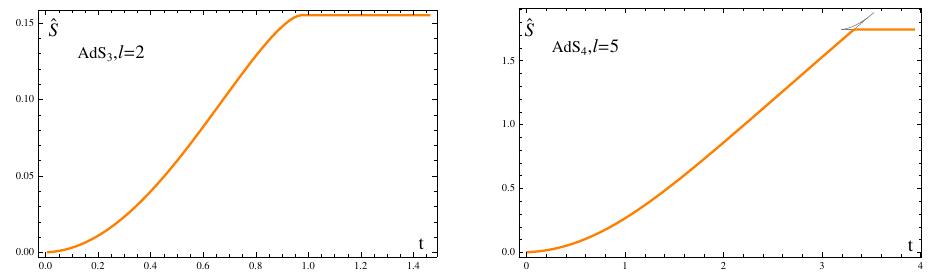
Figure 2 . The evolution of holographic entanglement entropy with respect to the boundary time t . We (cid:12)x M = 1 and v 0 = 0 : 01 here. The transition point in the right panel locates at t = 3 : 3248 ; ^ S = 1 : 7437.